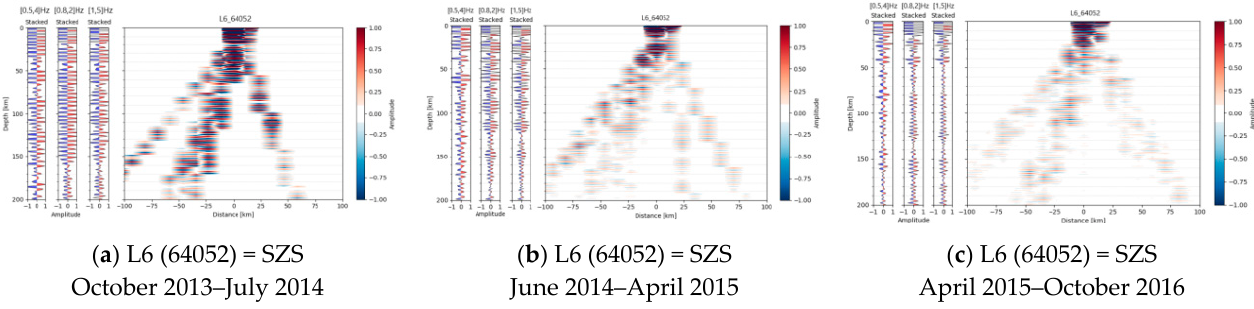
Figure 16. Variation characteristics of underground structure of 64052 (SZS) in different time peri- ods.